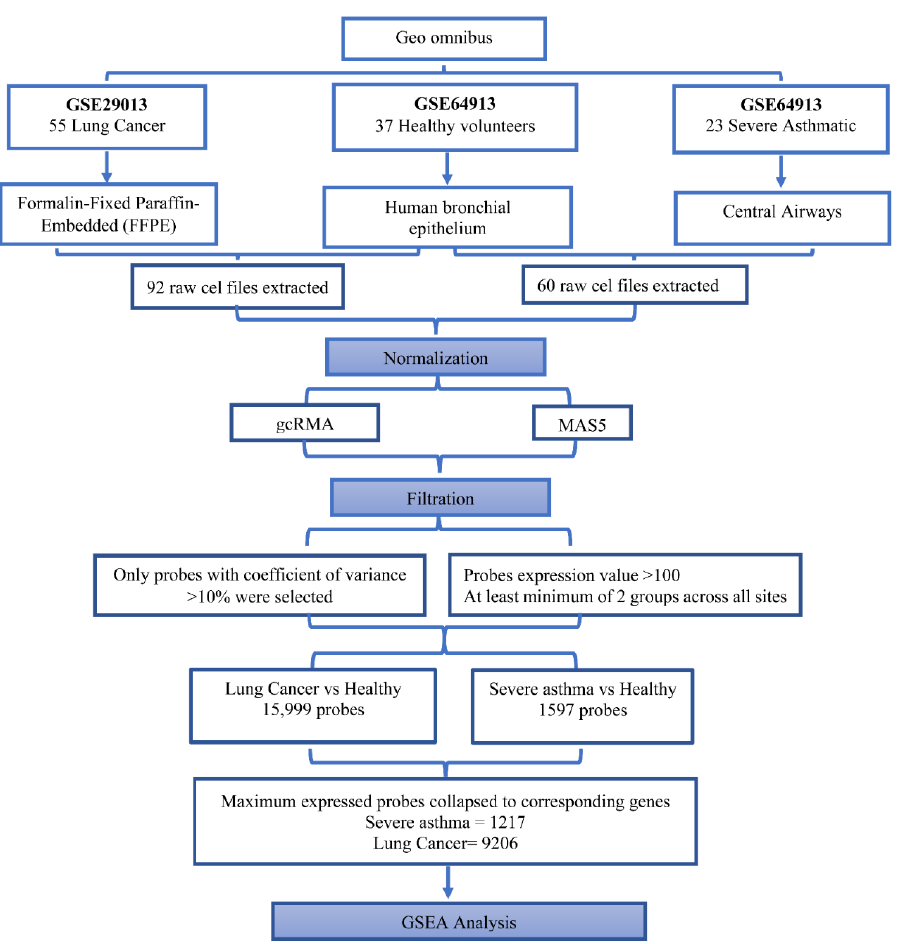
Figure 2. Flowchart outlining the steps of the bioinformatics approach used to identify differentially expressed genes in severe asthmatic bronchial epithelium compared to healthy controls and lung cancer compared to healthy controls. Abbreviations: GEO omnibus, Gene Expression Omnibus; gcRMA, guanine cytosine Robust Multi-Array Analysis; MAS5, Affymetrix Microarray Suite 5.